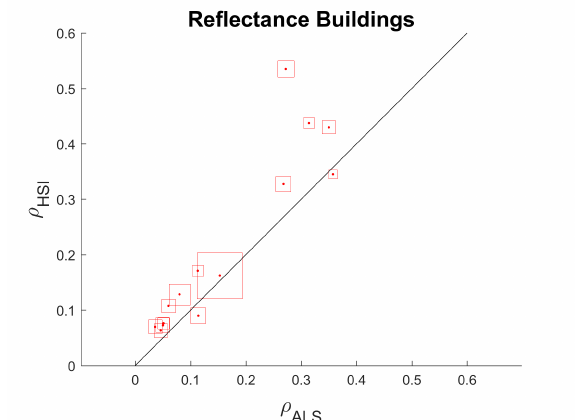
Figure 9: Reflectance comparison of ALS and HSI data for roof tops. The size of the red squares corresponds to the area of the respective roof top.